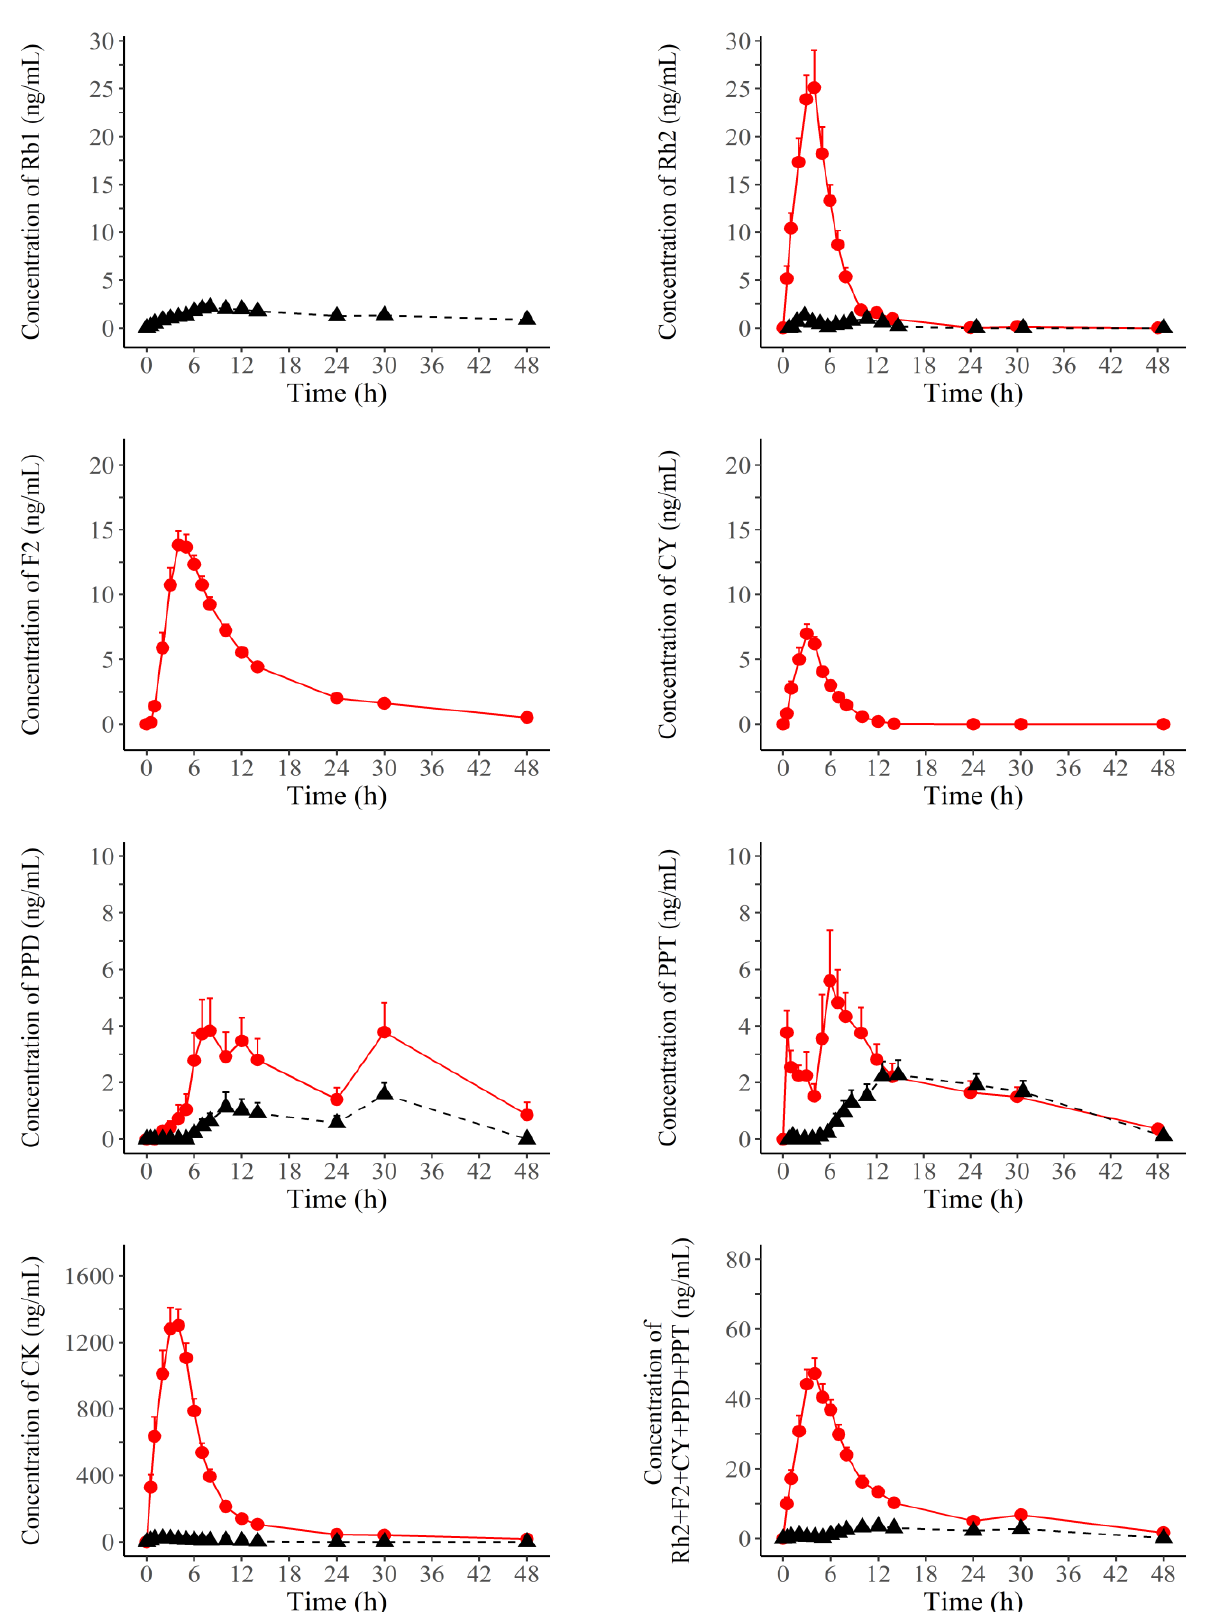
Figure 2. Mean plasma concentration kinetics of ginsenosides after receiving a single dose of 6 g of fermented red ginseng (red filled circles and red solid line) or red ginseng (black filled triangles and black dashed line).